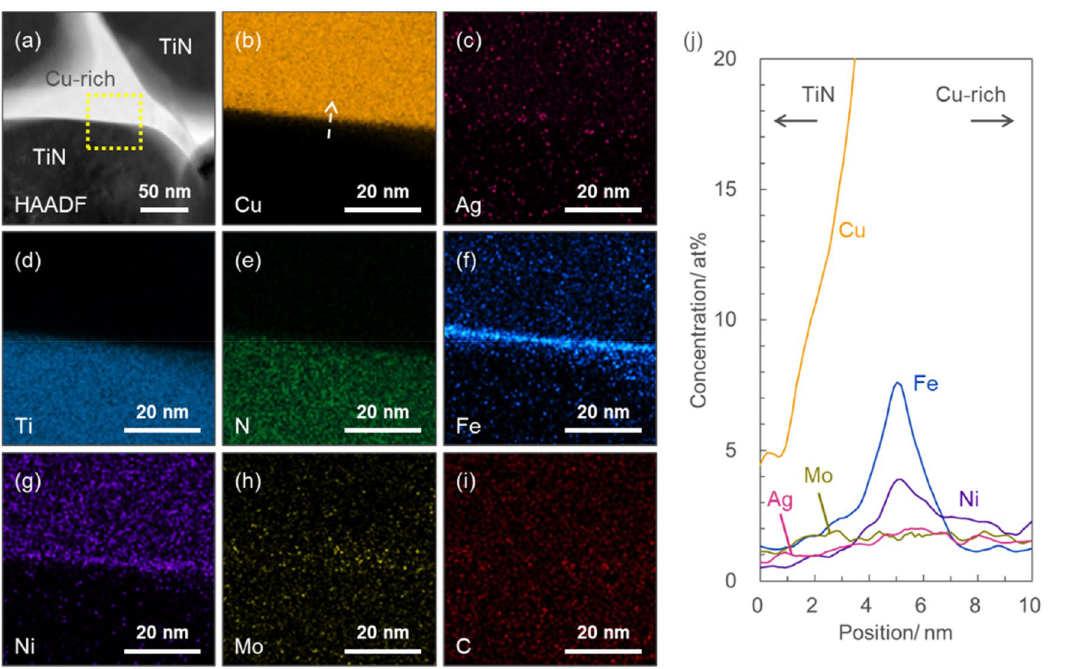
C obtained from the selected area marked in ( a ) by EDS. j Line EDS profile obtained along the white dashed arrow shown in ( b )